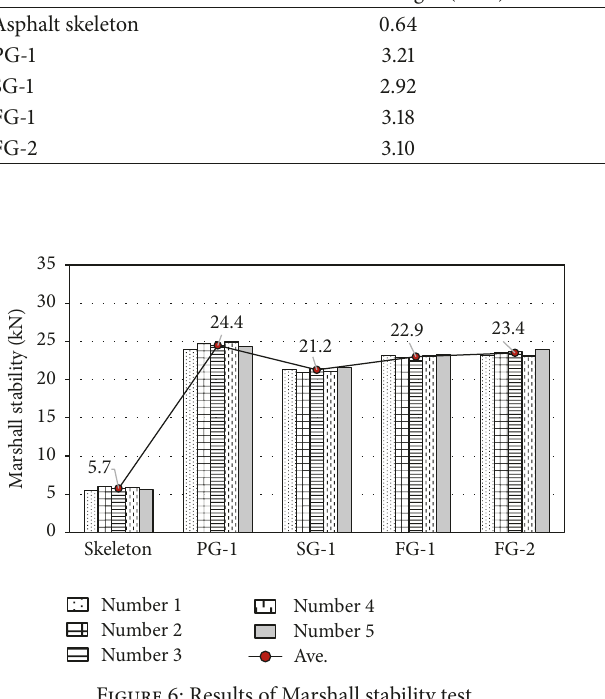
Figure 6: Results of Marshall stability test.